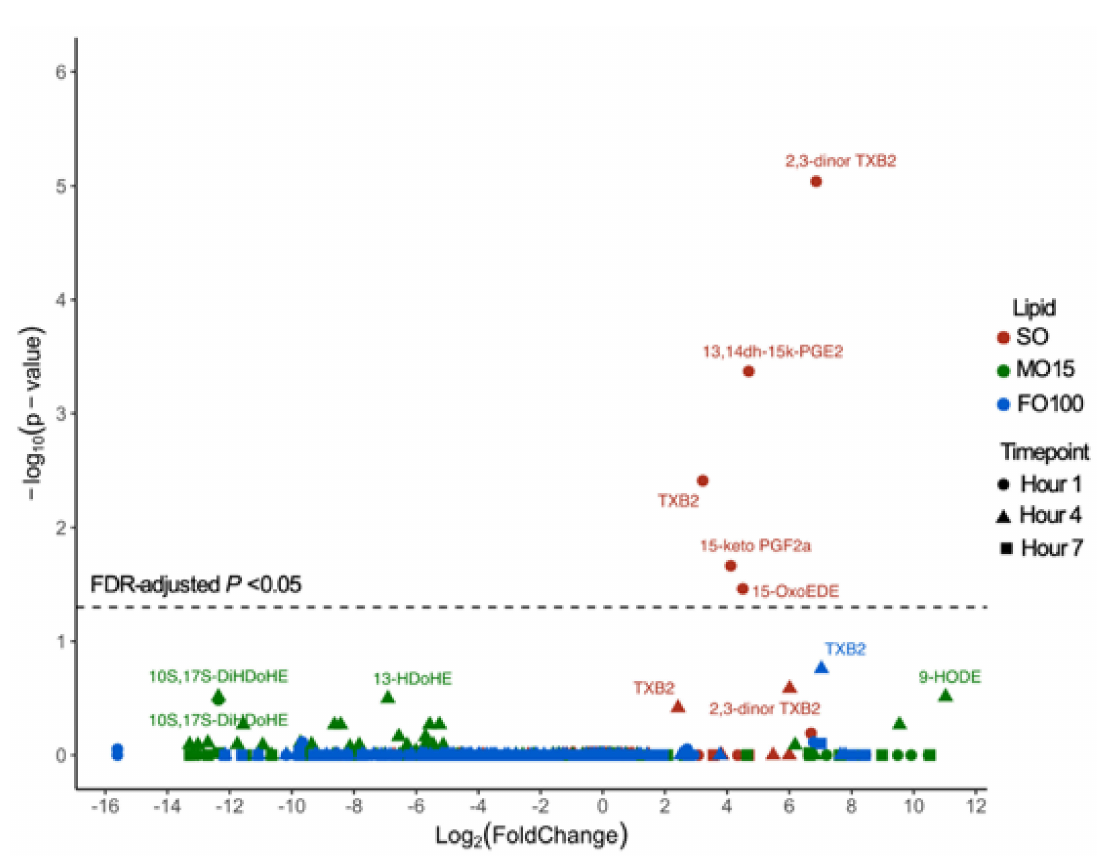
Figure 7. Changes in plasma oxylipins during LPS infusion. Scatter plot shows the median fold change of oxylipins at different hours of infusion (shape) compared to baseline on day 11 within each lipid group, SO (red, n = 10), MO15 (green, n = 9), and FO100 (blue, n = 10). AA, arachidonic acid; ALA, α -linolenic acid; DGLA, dihomo- γ linolenic acid; DHA, docosahexaenoic acid; EPA, eicosapentaenoic acid; FO100, 100 percent fish oil; LPS, lipopolysaccharide; LA, linoleic acid; MO15, mixed oil with 15% fish oil; SO, 100% soybean